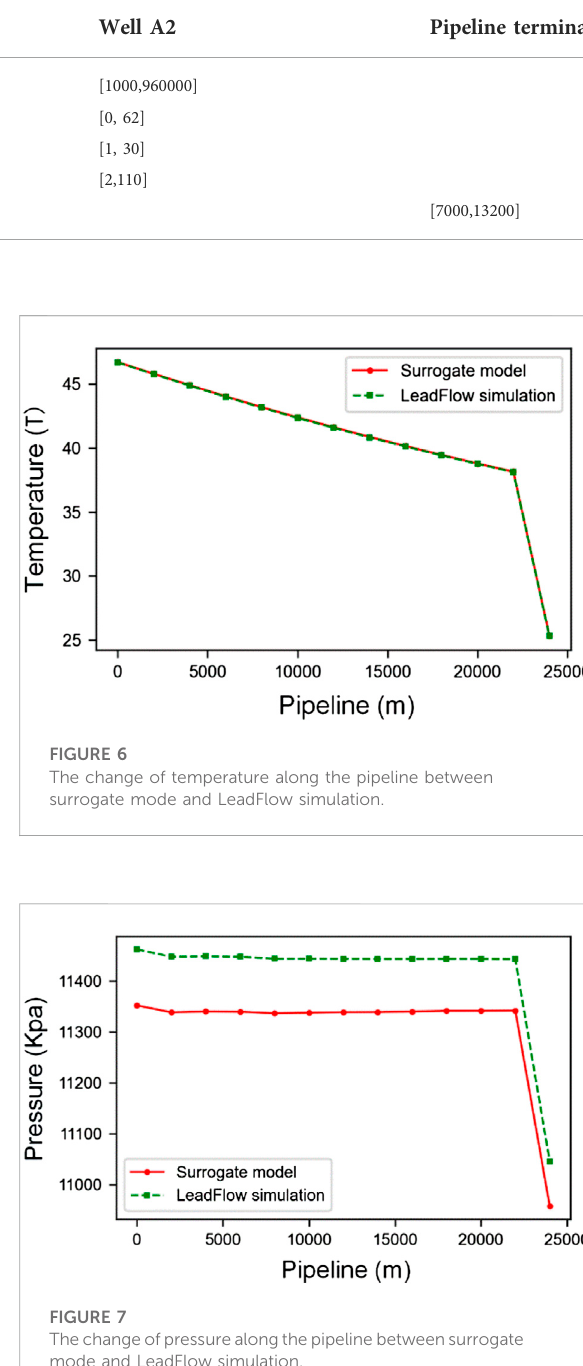
TABLE 1 The input data range of pipeline simulation for multi-example.